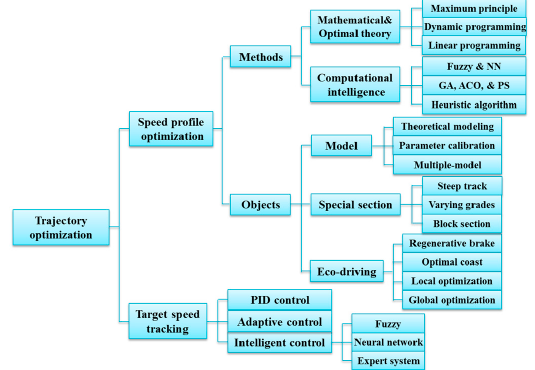
Figure 1. Methodology tree of energy ‐ efficient train operation.